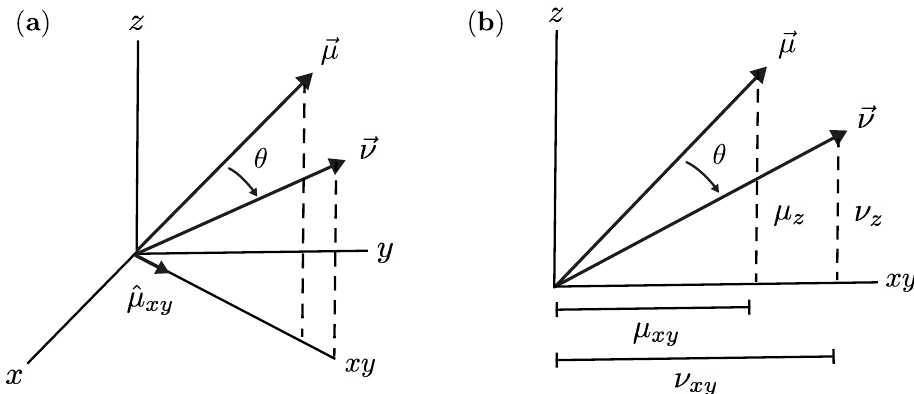
Figure A1. Polar rotation of the magnetic moment. ( a ) the three-dimensional (3D) representation and ( b ) the two-dimensional (2D)